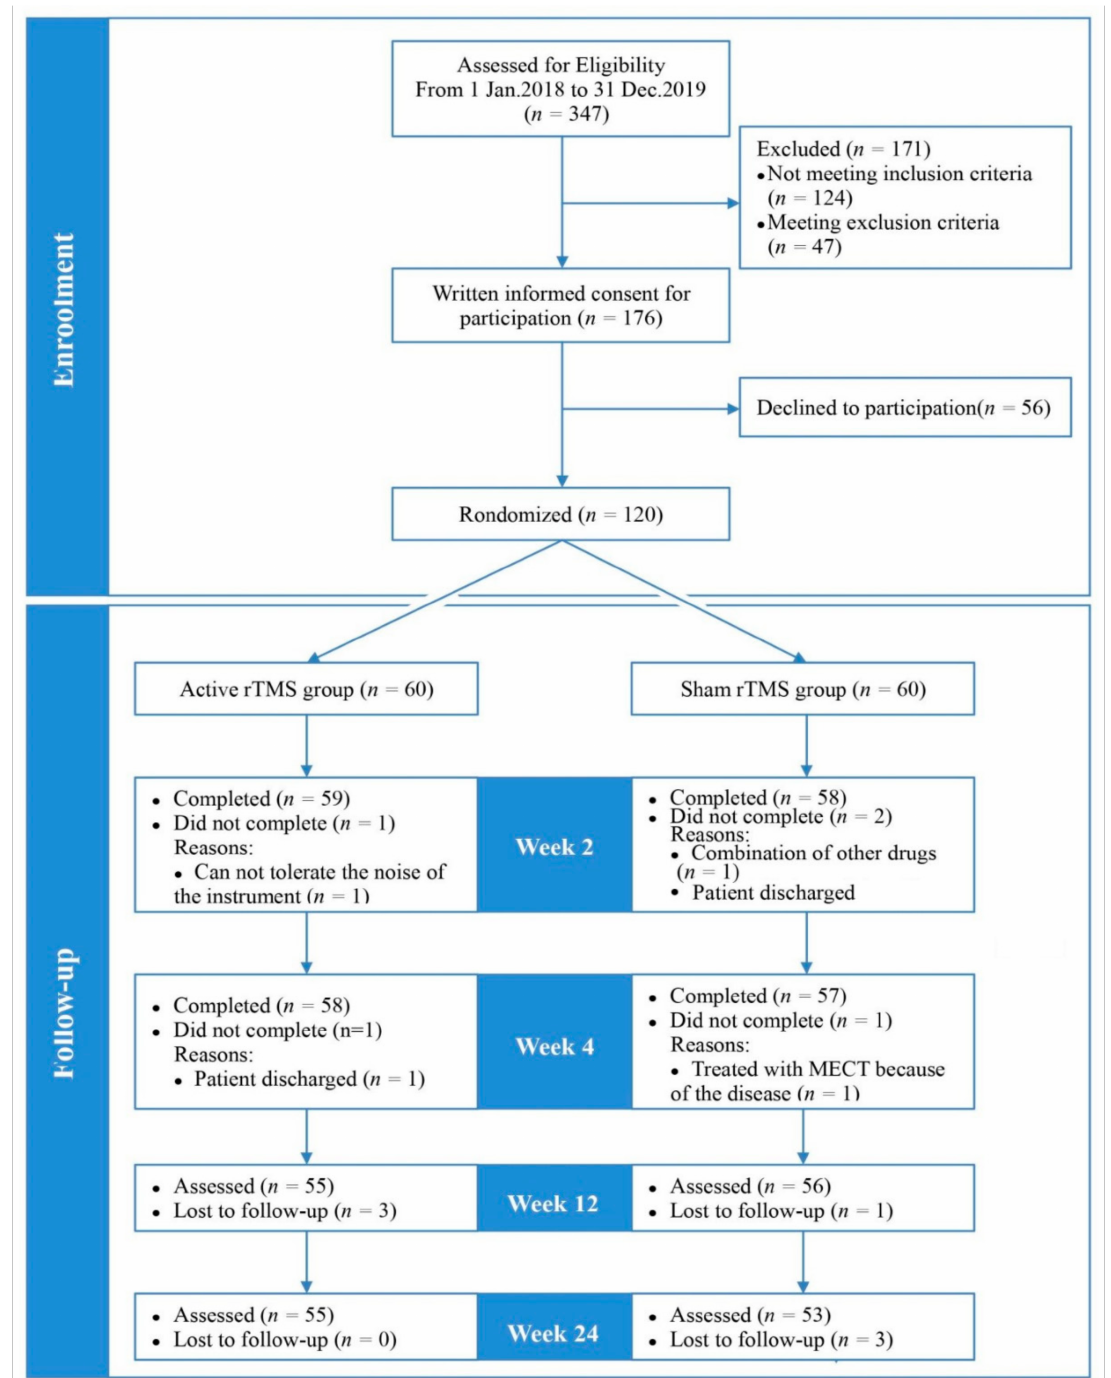
Figure 1. Sample flow diagram depicting the flow of participants through the